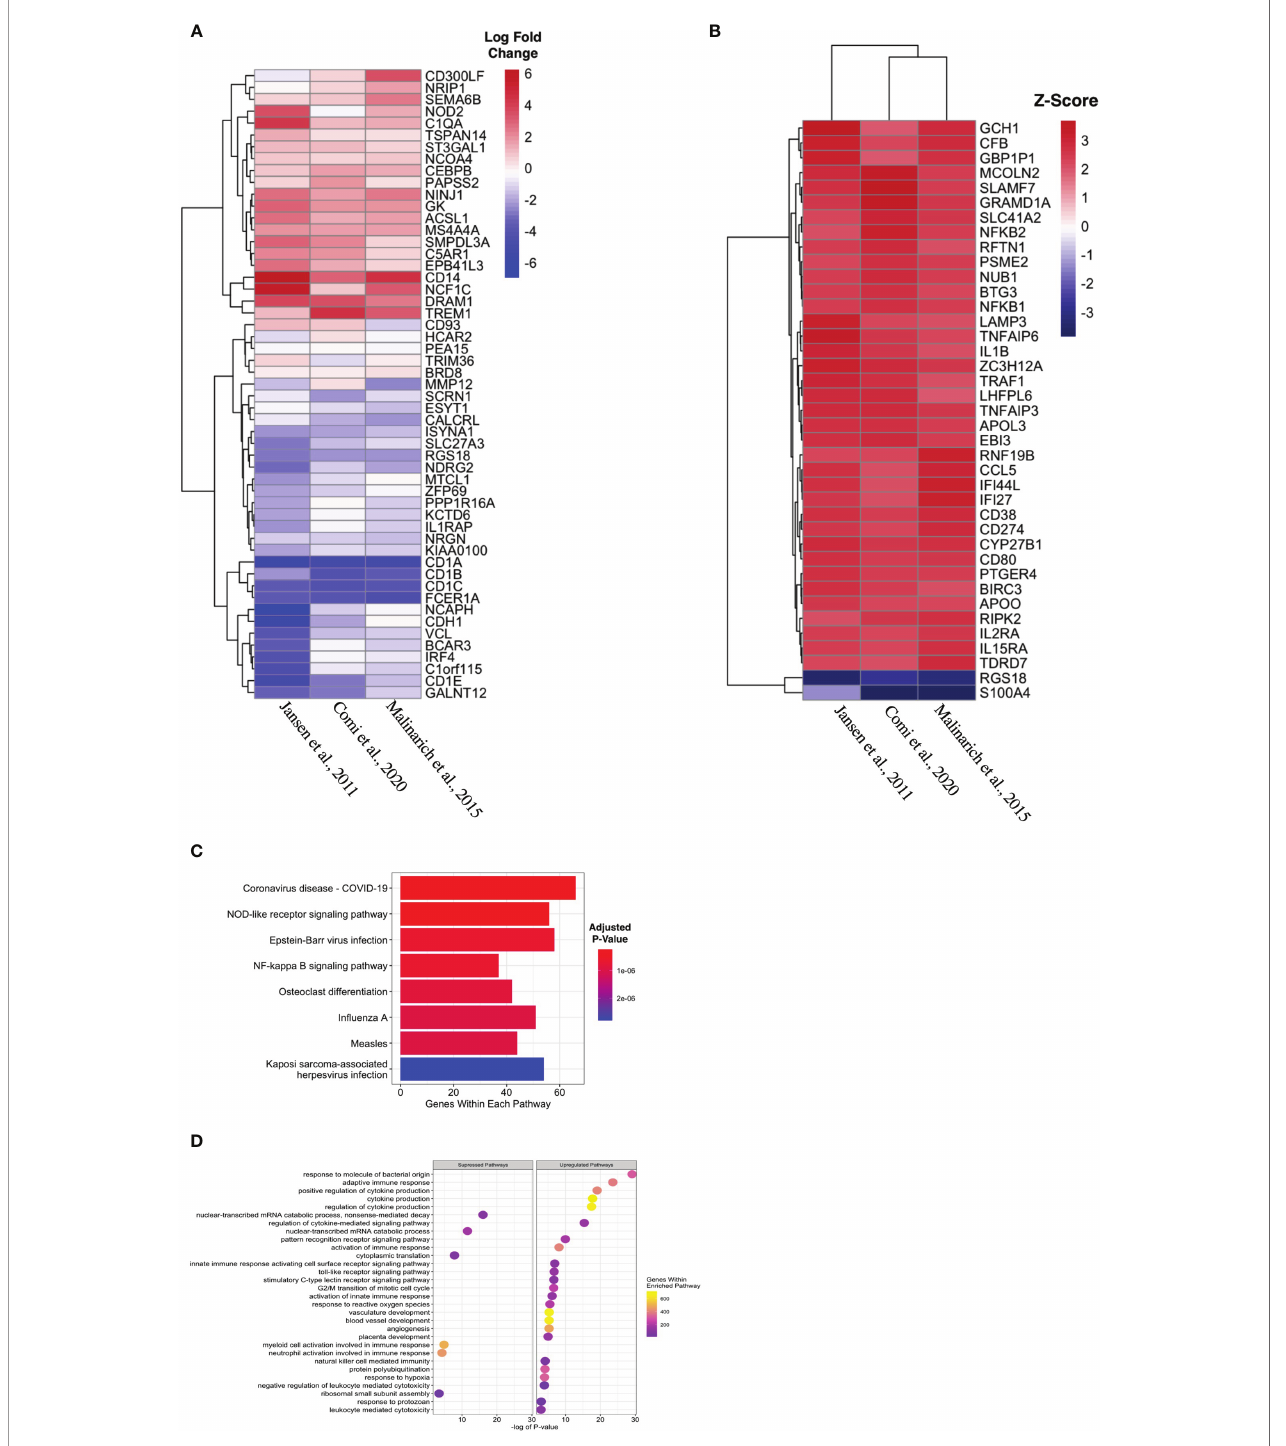
FIGURE 4 | Identifying transcriptomic differences between subtypes of tolDC. (A) Heatmap representation of the top 39 DEG by AADC. (B) Fold change difference in expression of genes in AADC compared to tolDC. (C) KEGG and (D) Gene Set Enrichment